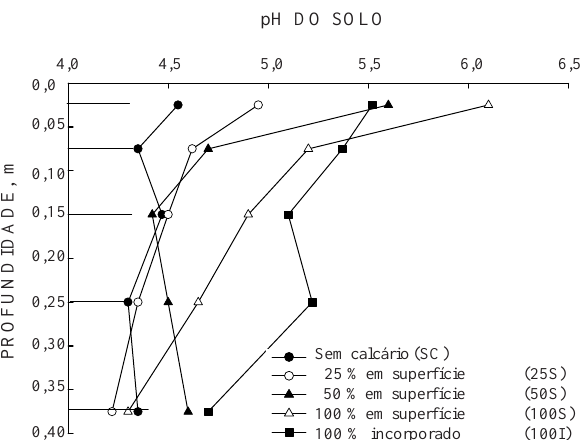
Figura 1. Valores de pH em água em cinco camadas do Argissolo Vermelho distrófico arênico cultivado com milho sob semeadura direta. Barras horizontais representam o